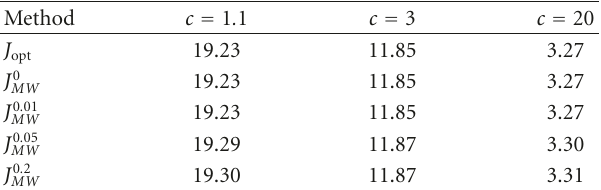
Figure 8: Number of averaged multitaper spectrograms K for di ff erent values of c ; solid line = δ = 0 . 01, dashed line = δ = 0 . 05, dash-dotted line = δ = 0 . 2. Table 5: Results of the MSE of the LSP for di ff erent parameter choices using Hermite functions as windows and a decreasing number of eigenvalues, N = 256 and F s = 7.